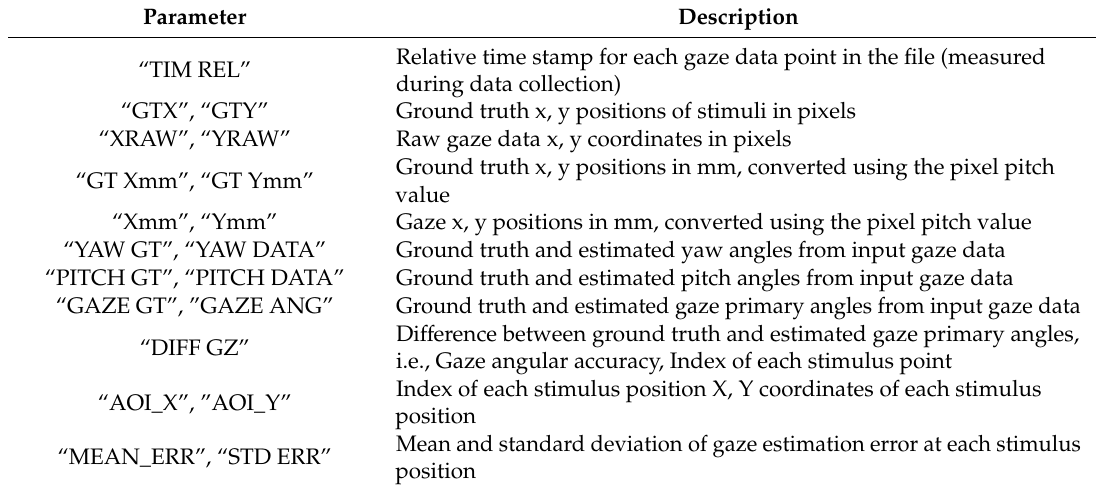
Table 5. Columns in a gaze data file from the NUIG_EyeGaze01dataset and their meaning.